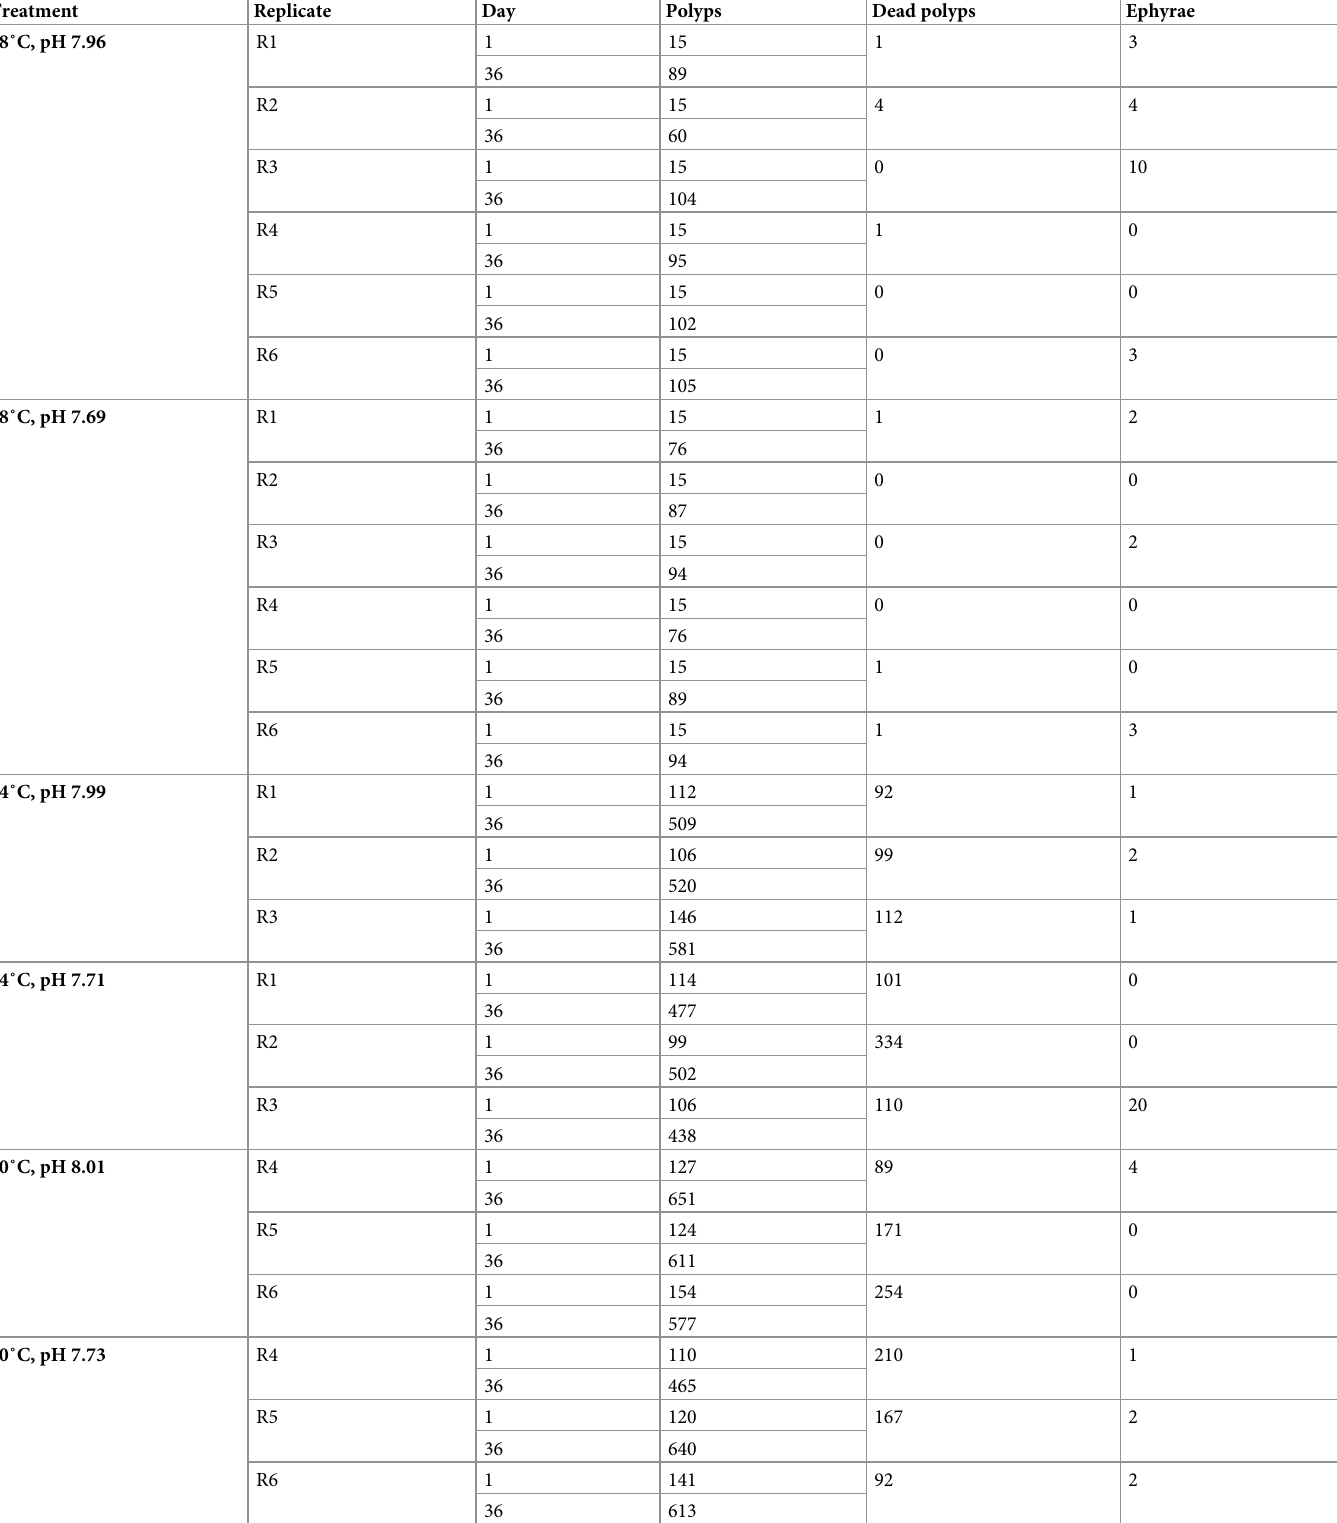
Table 3. Number of polyps, number of dead polyps and number of released ephyrae counted at the beginning and at the end of the experiment.